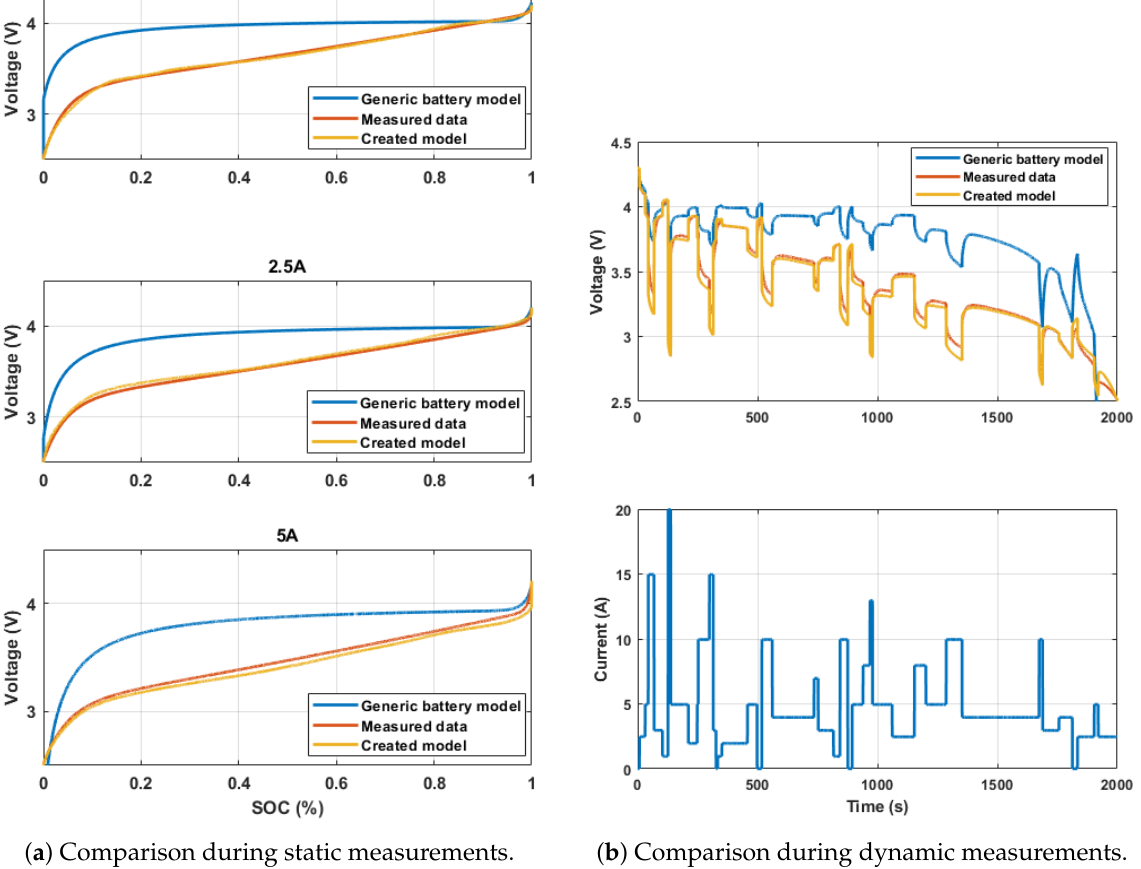
Figure 26. Comparison of ( a ) static measurement and ( b ) dynamic measurements for SoH =